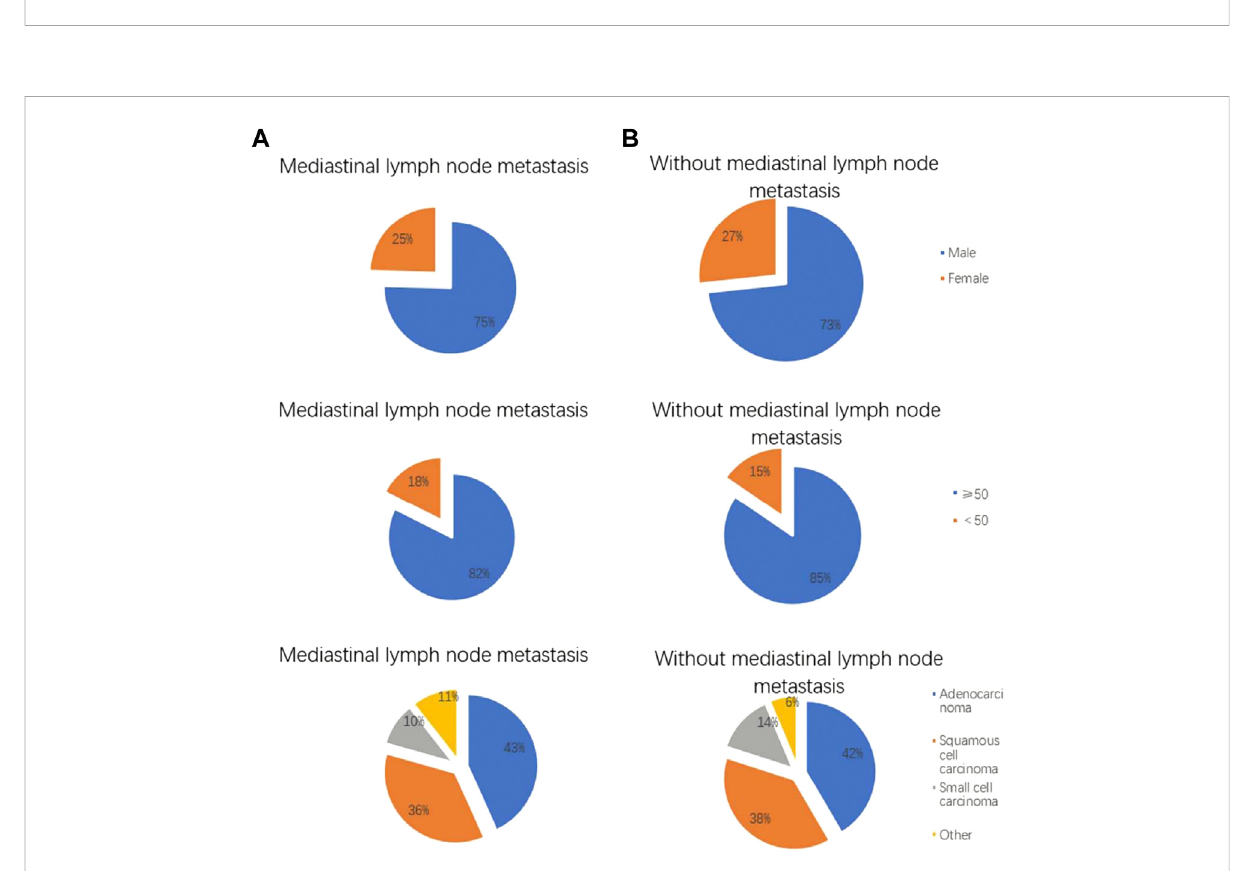
FIGURE 2 Clinical features of lung cancer patients with and without mediastinal lymph node metastasis. The (A) shows lung cancer patients with mediastinal lymph node metastasis, and the (B) shows lung cancer patients without mediastinal lymph node metastasis. Gender distribution of lung cancer patients with and without mediastinal lymph node metastasis. Age distribution of lung cancer patients with and without mediastinal lymph node metastasis. Pathological features of lung cancer patients with and without mediastinal lymph node metastasis.